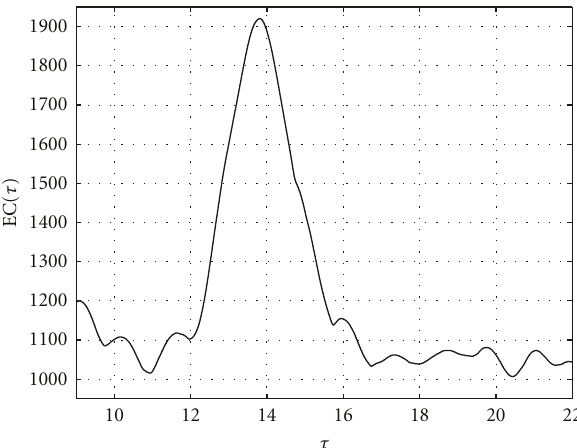
Figure 1: Envelope correlation (as a function of the range shift τ ) between a real shifted range profile and its corresponding reference profile.